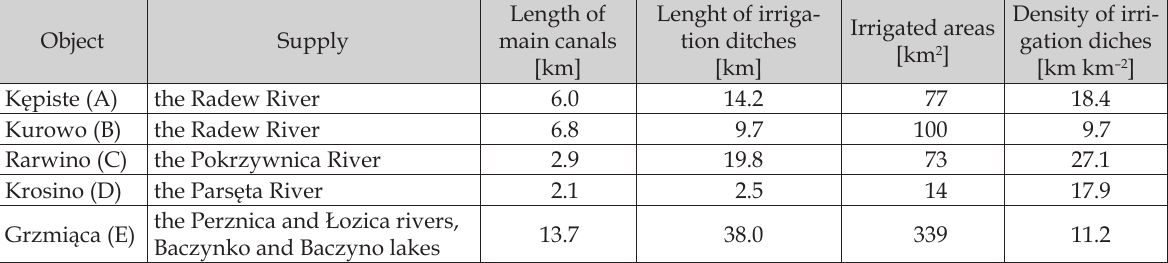
Table 1. Parameters of the selected irrigation objects in the Parsęta